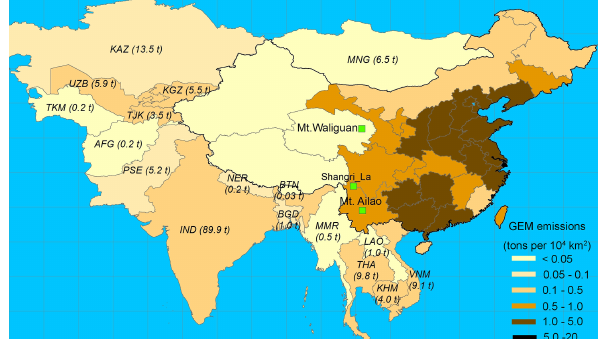
Figure 1. Locations of the three ground-based remote sites in north- western and southwestern China as well as the annual anthro- pogenic GEM emission for studied Asian countries (Wu et al., 2006; AMAP/UNEP,